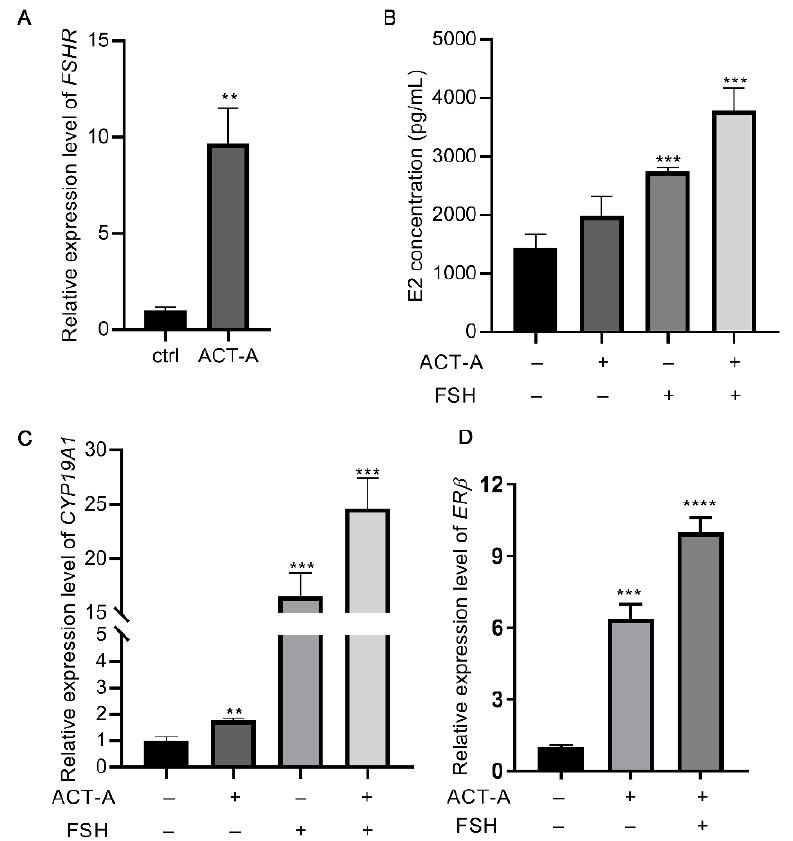
Figure 1. Effect of ACT-A on ER β and FSHR expression and GC sensitivity to FSH therapy. qRT- PCR was used to evaluate the gene expression level of FSHR ( A ), CYP19A1 ( C ), ER β ( D ), and E2 concentration levels in GCs ( B ). The ctrl means control (untreated group). ** p < 0.01, *** p < 0.001, **** p < 0.0001.